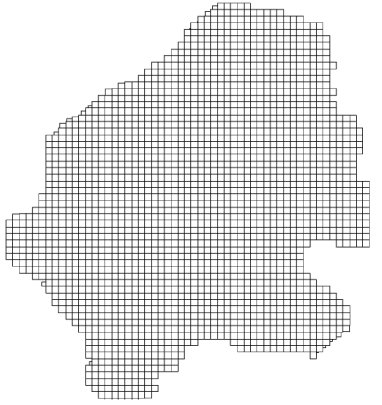
Figure 7. The Gilmer county LiDAR dataset